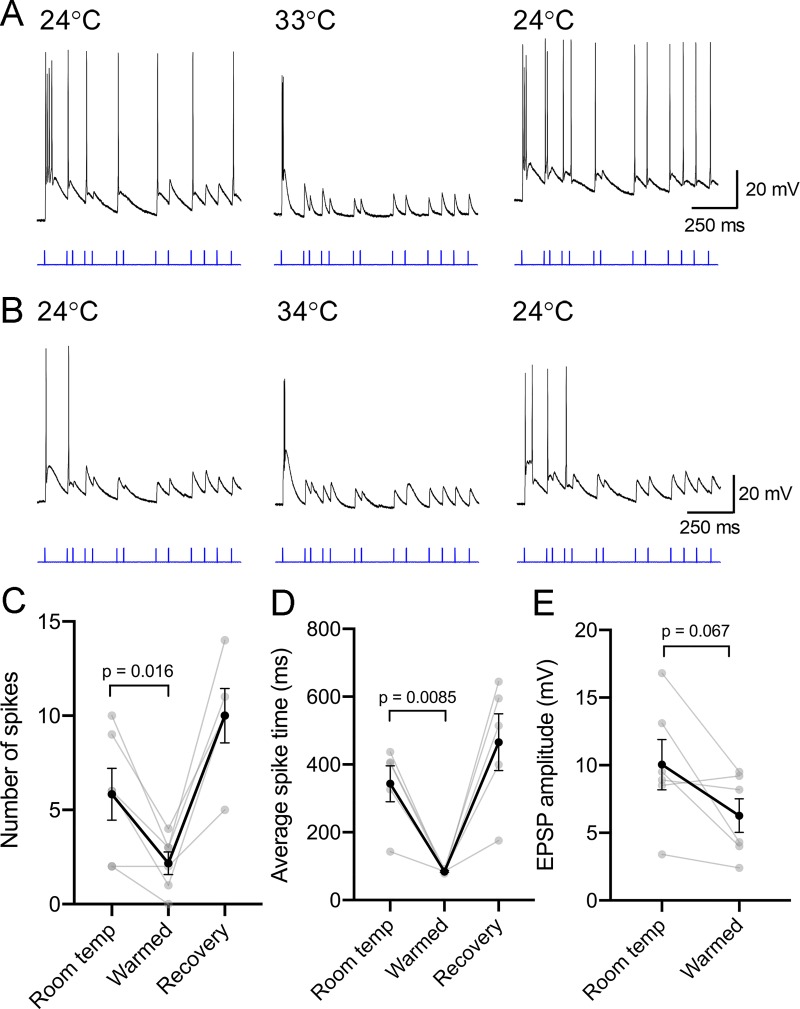
Warming reduces the spiking responses of dLGN thalamocortical relay neurons to optic tract stimulation.A & B) Whole-cell current clamp recordings of two example dLGN TC neurons from Chx10-Cre;Ai32 mice in which a 460 nm LED was used to deliver a stimulus sequence (blue) derived from a retinal ganglion cell spike train. Warming ultimately reduced the responses of the TC neurons, concentrating spiking to the first stimulus flash. C) The number of spikes evoked during the stimulus sequence was reduced by warming the bath and recovered following return to room temperature conditions. D) The average of the peak time of each spike in the stimulus sequence was used to examine the distribution of spikes over the sequence. The average peak time shifted to smaller values in warmed conditions, indicating that spikes were more concentrated to the beginning of the stimulus sequence. E) The amplitude of sub-spike threshold EPSPs at a point in the sequence that reliably did not evoke a spike was measured in each of the six cells and was slightly reduced by warming, although the change was not statistically significant.